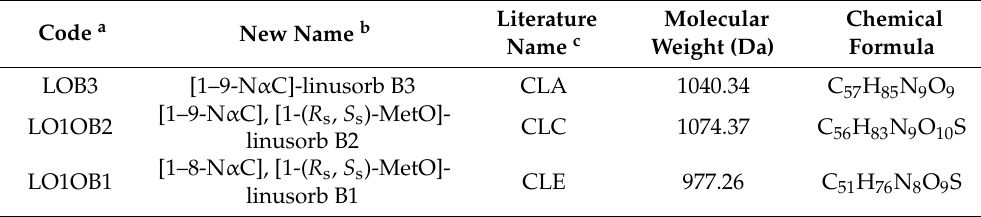
Table 1. Primary structures of select